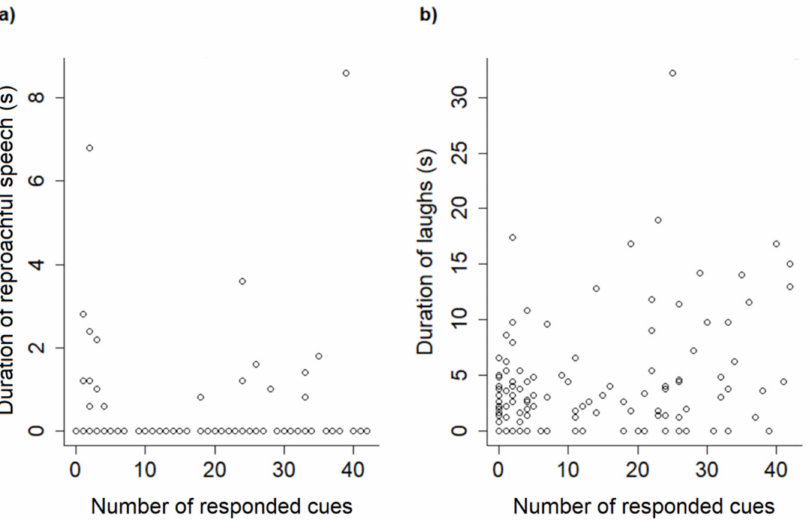
Figure 4. Dispersion of the duration of trainers’ reproachful speech ( a ) and laughter ( b ) during training sessions with shelter and companion dogs as a function of the number of cues responded to per session.